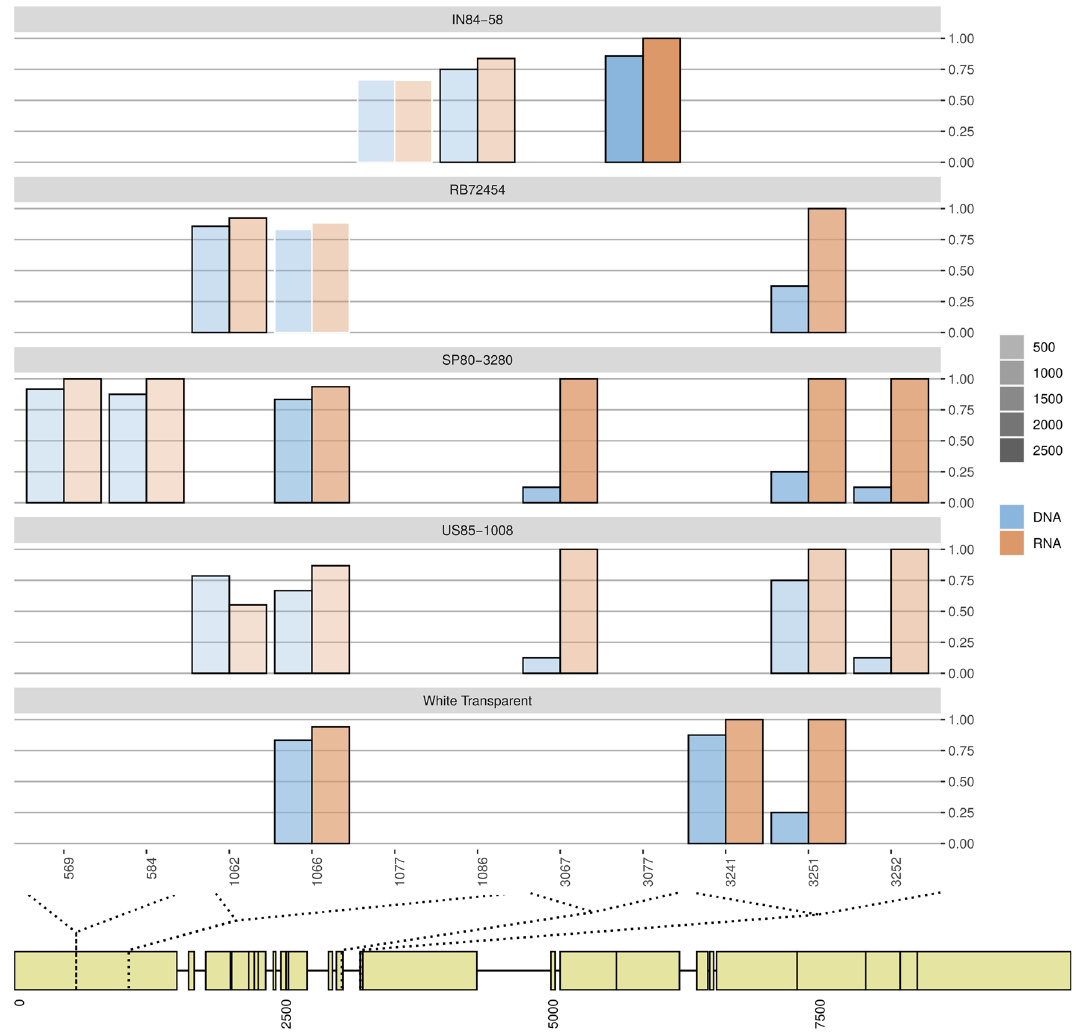
Figure 3. Relative genomic dosage and relative expression of the reference allele from SNPs identified in the gene coding for UTP–glucose-1-phosphate uridylyltransferase . Relative genomic dosage of the allele is represented by a blue bar. The expressed proportion of each allele is represented by orange bars. SNPs showing ASE have black borders, while those not showing ASE have white borders. Color gradient represents the expression level of the allele. The bottom part of the plot shows a schematic view of the transcript showing the position of the